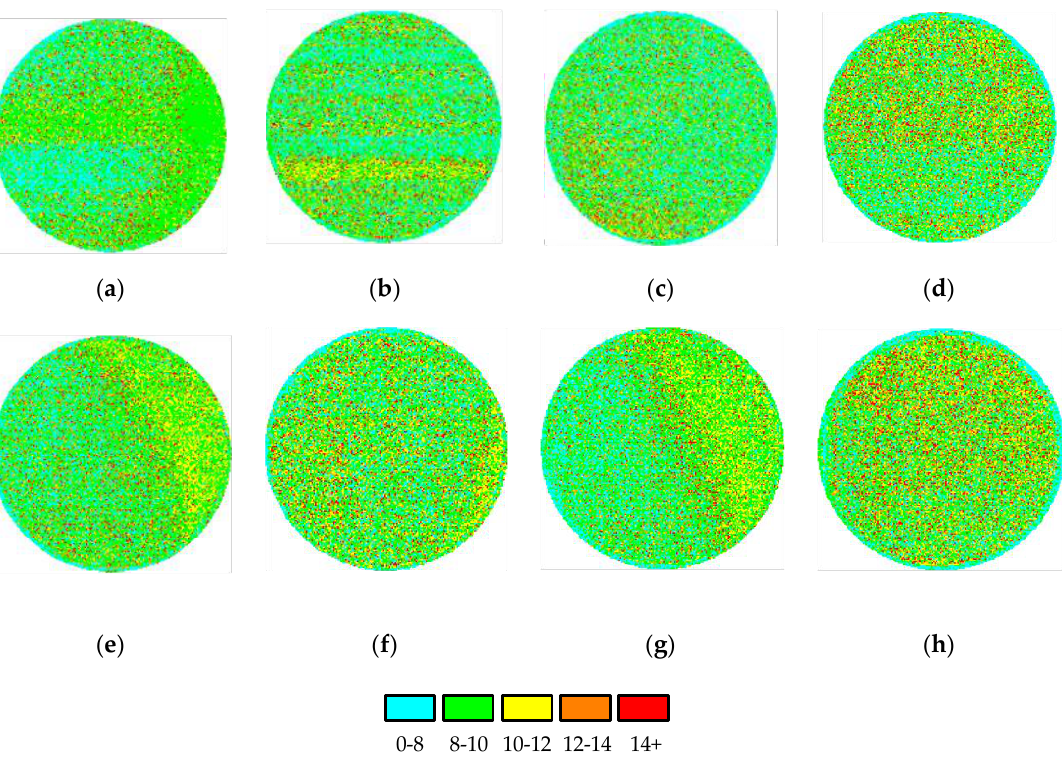
Figure 6. Soil TAs concentration distribution maps (Label value is soil sample of arsenic concentration measured with atomic fluorescence spectrometry) . ( a ) Sample a 7.04 (µg/g) ; ( b ) sample b 8.26 (µg/g) ; ( c ) sample c 8.69 (µg/g) ; ( d ) sample d 9.36 (µg/g) ; ( e ) sample e 10.58 (µg/g) ; ( f ) sample f 11.05 (µg/g) ; ( g ) sample g 11.25 (µg/g) ; ( h ) sample h 16.41 (µg/g). Table 4. Statistical summary of the TAs distribution